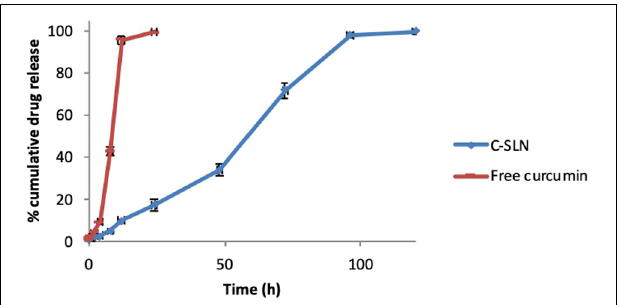
FIGURE 3 | In vitro release profile of curcumin from CLEN and free curcumin.